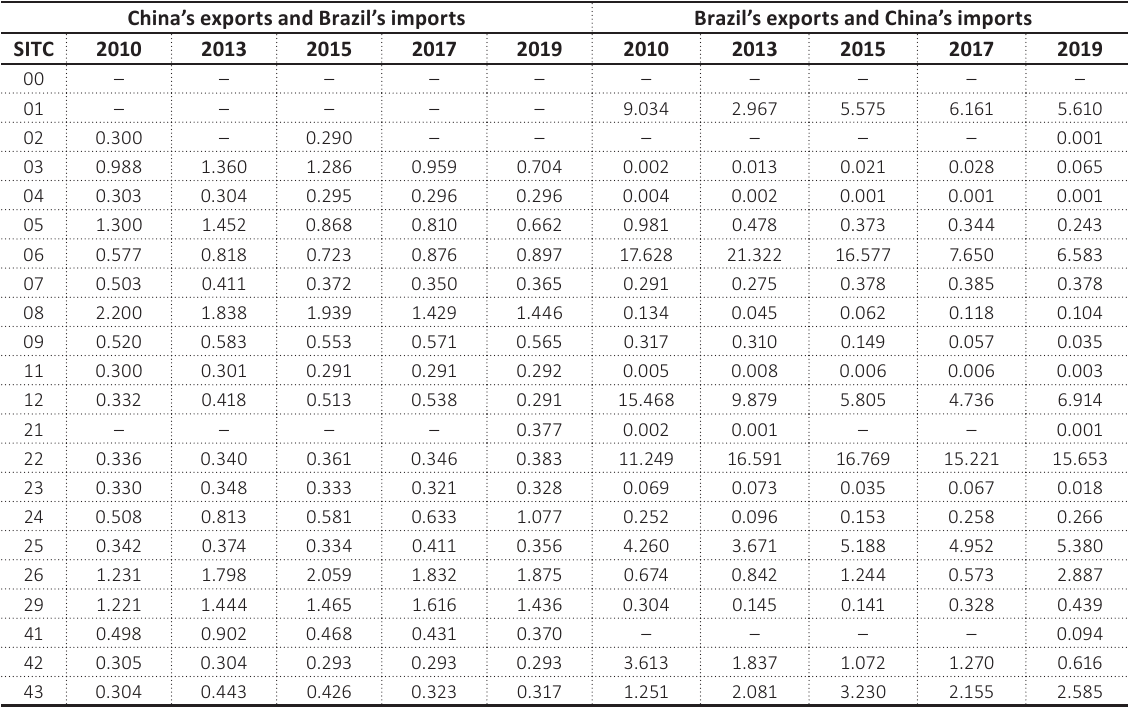
Table 4. China and Brazil’s agricultural trade complementarity index China’s exports and Brazil’s